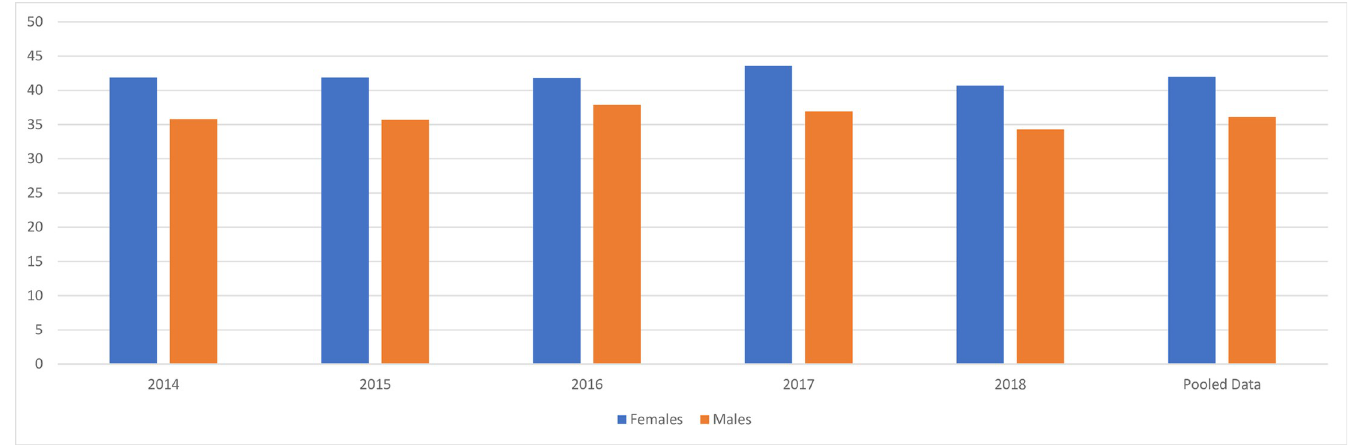
Fig 1. Participants’ General Health Questionnaire 12-item scores by gender. The levels of the General Health Questionnaire 12-item scores: 0 = � 3 points, 1 = � 4 points. Results of GHQ scores by gender: 2014: ��� p < .001, 2015: ��� p < .001, 2016: � p < .05, 2017: ��� p < .001, 2018: �� p < .01, Pooled data: n.s.